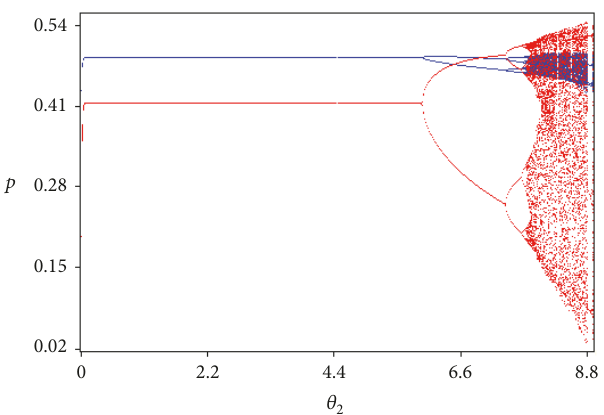
Figure13:Bifurcationdiagramof 𝑝 withrespectto 𝜃 2 when 𝜃 1 = 1.2 .